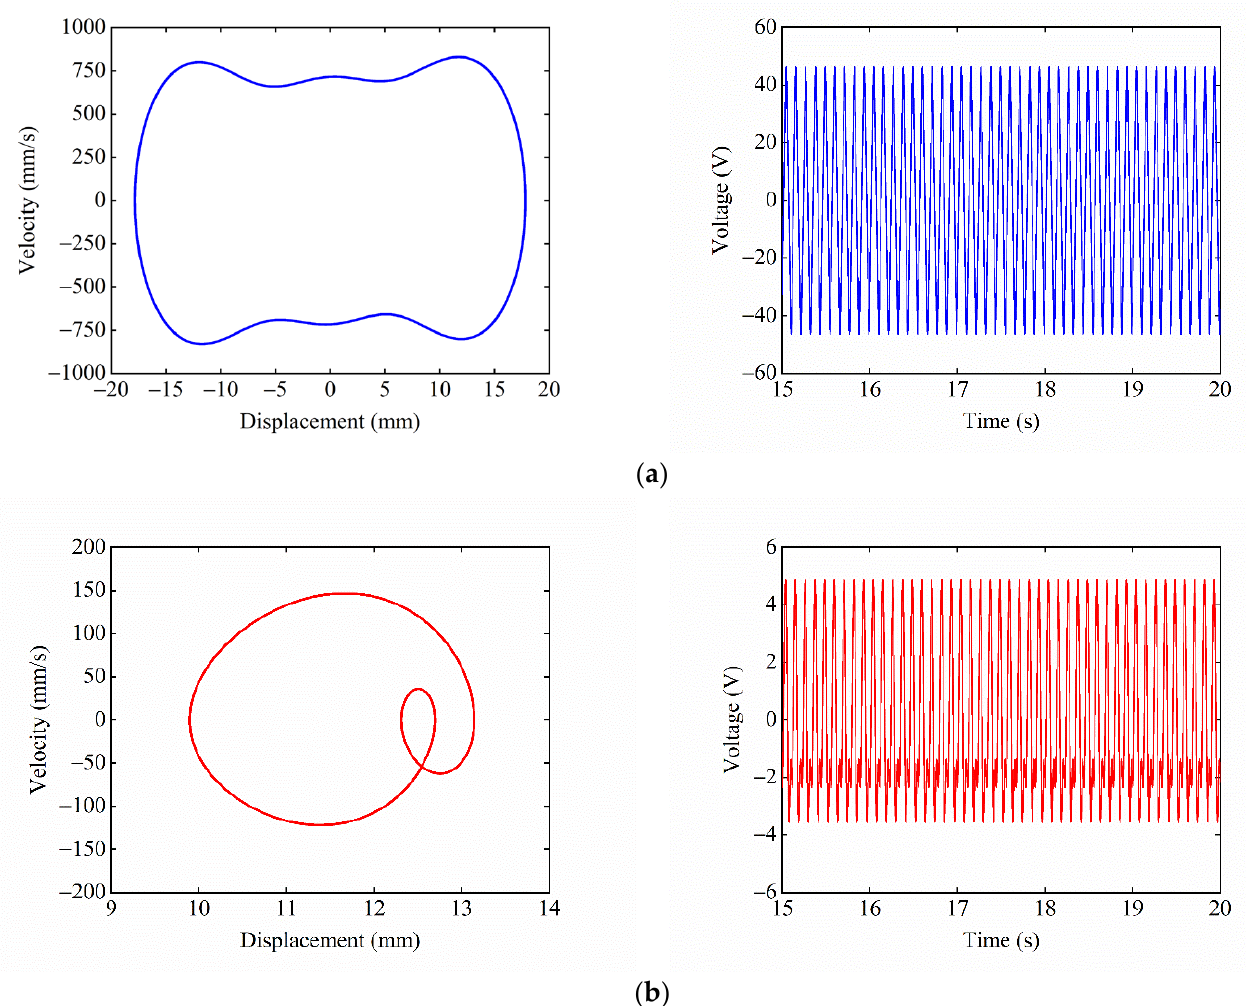
: ( a ) starting 𝛥𝛥𝑈𝑈 1 < 𝛥𝛥𝑈𝑈 2